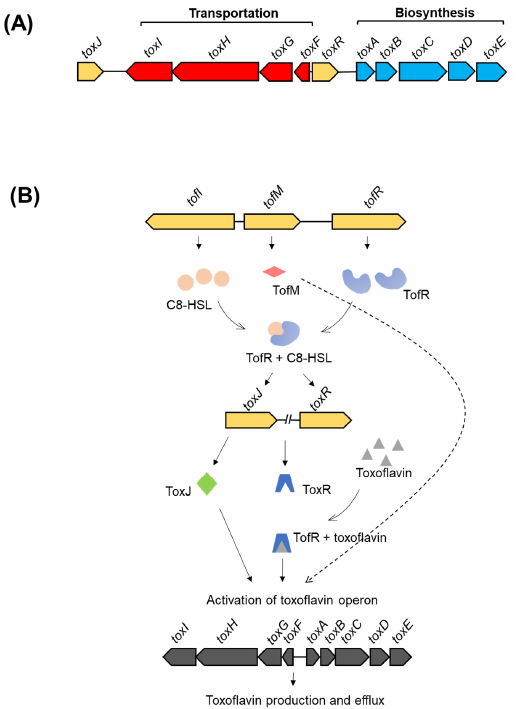
Figure 2. ( A ) A schematic representation of the tox operon for toxoflavin production and transport. Biosynthetic genes are shown in blue, transportation genes in red, and regulatory genes in